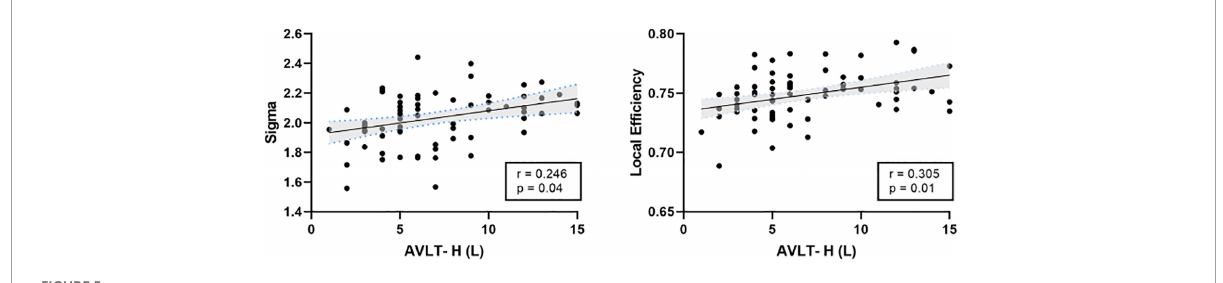
FIGURE5 Correlations between cognitive test score and the topological properties. AVLT-H (L), Auditory verbal learning test-Huashan version for long